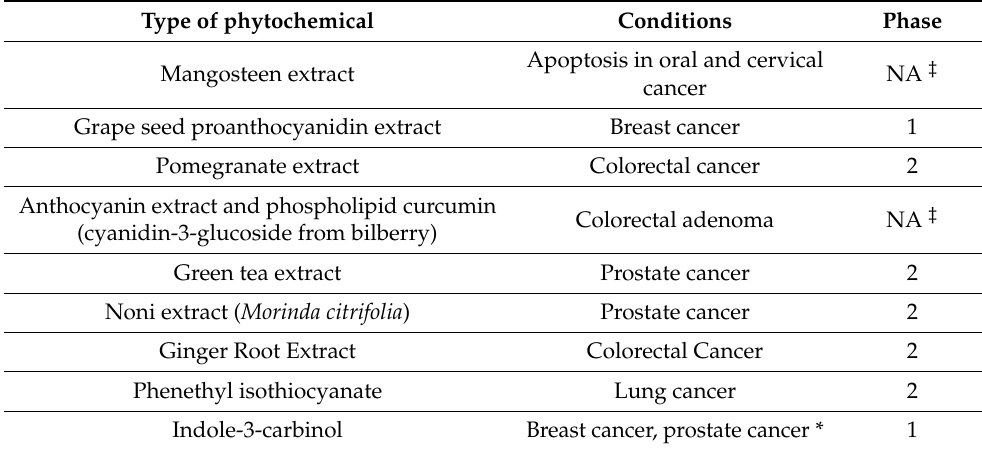
Table 3. Anti-cancer effects of phytochemicals in different stages of the FDA clinical trials